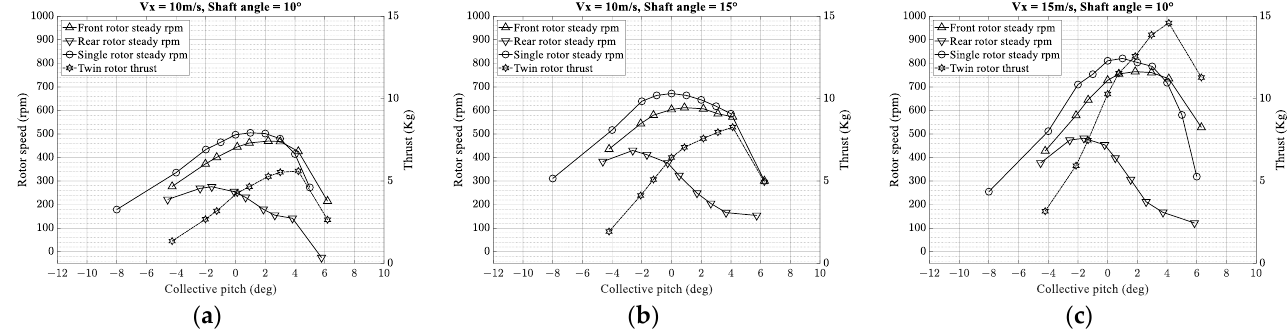
Figure 10. Wind Tunnel Data of Steady Rotor Speed of Tandem Rotor in Comparison with Isolated Rotor in Autorotation at ( a ) V x = 10 m/s, θ = 10 deg; ( b ) V x = 10 m/s, θ = 15 deg; ( c ) V x = 15 m/s, θ = 10 deg.